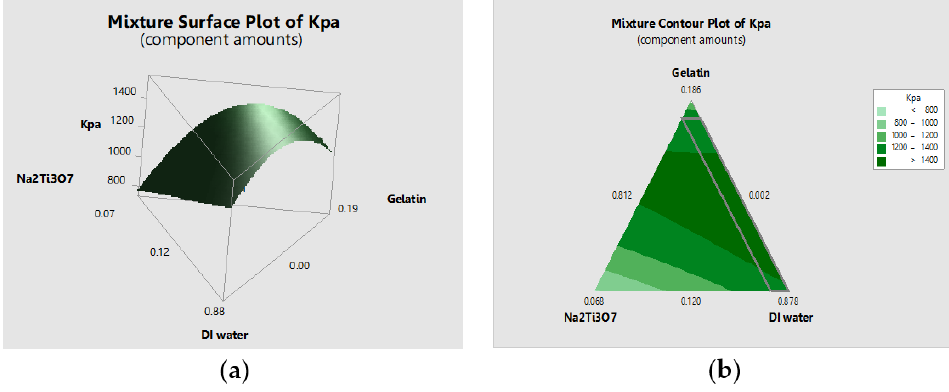
Figure 2. Mixture surface and mixture contour plot. Figure 2. ( a ) Mixture surface and ( b ) mixture contour plot.